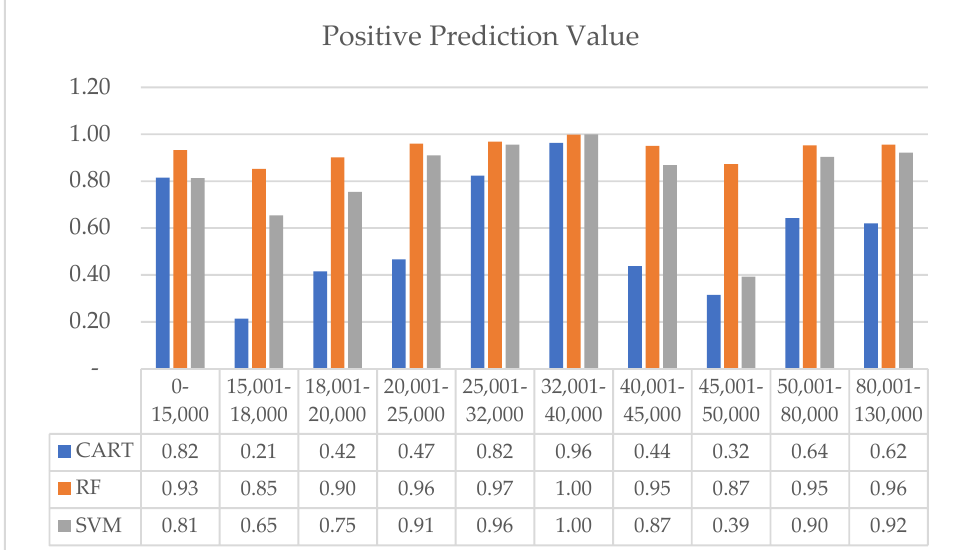
Figure 9. The positive prediction values distribution of all models. Figure 10 shows the negative prediction value distribution of all models. In the negative prediction value, all models had high negative prediction values. Specifically, RF found a value equal to 1 at almost every land value distribution. Except for 32,001–40,000 THB/Wah 2 .